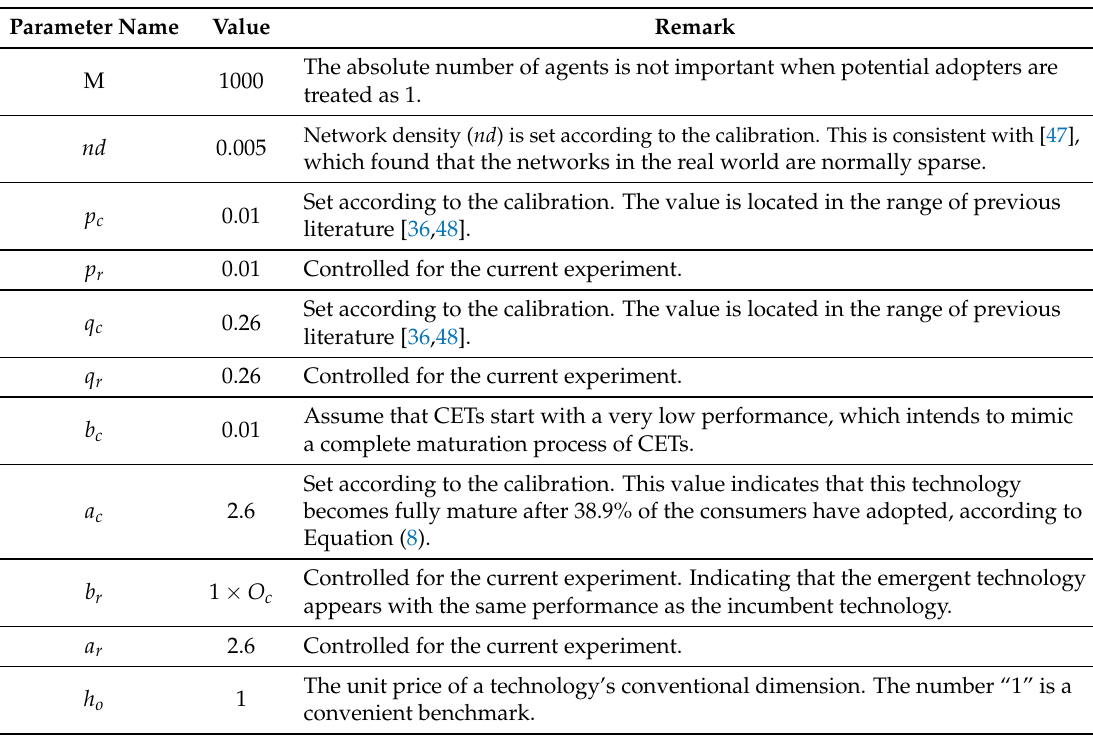
Table 1. Parameter settings of the one-dimensional competition